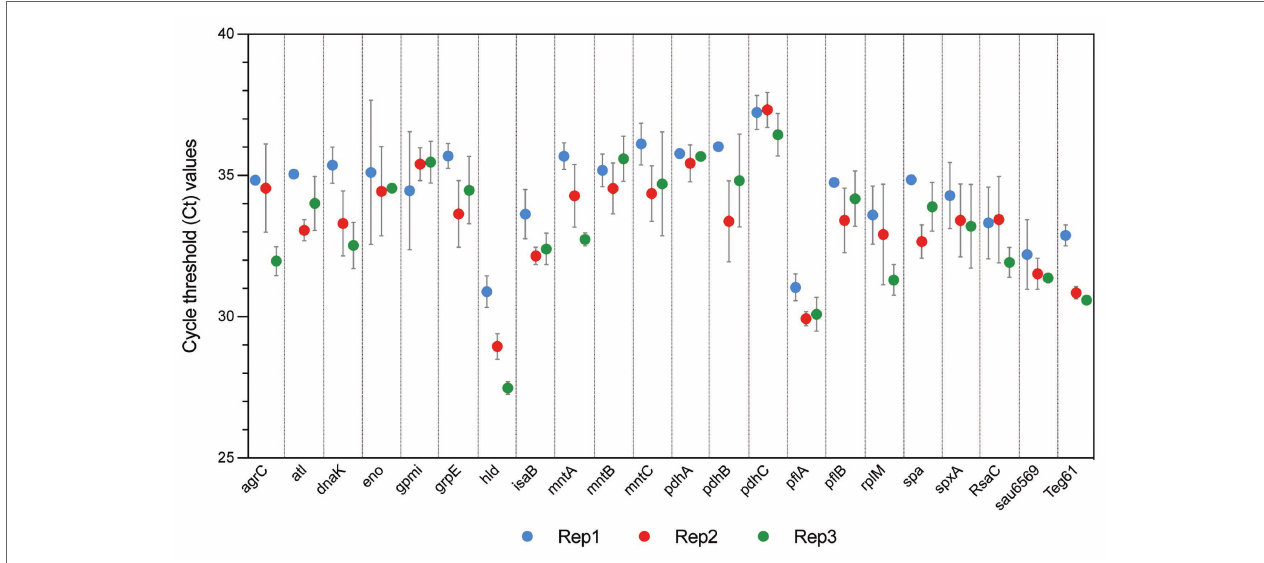
FIGURE 5 | Reverse transcription quantitative PCR (RT-qPCR) validation of S. aureus HG003 EV RNAs. RT-qPCR experiments were performed from RNAs extracted from EV samples isolated from the cell-free supernatants of three independent S. aureus cultures at late-stationary growth phases (12 h) in the absence of vancomycin (Rep1, Rep2, and Rep3). Quantitative PCR (qPCR) successfully amplified the coding-sequence of 19 mRNAs, and 3 sRNAs. Samples setups included biological triplicates (Rep1, Rep2, and Rep3) and technical duplicates as well as negative controls corresponding to qPCR reactions performed without cDNA, and from RT reactions performed without reverse transcriptase enzyme. Ct values are expressed as mean ± SD from two independent technical replicates performed in